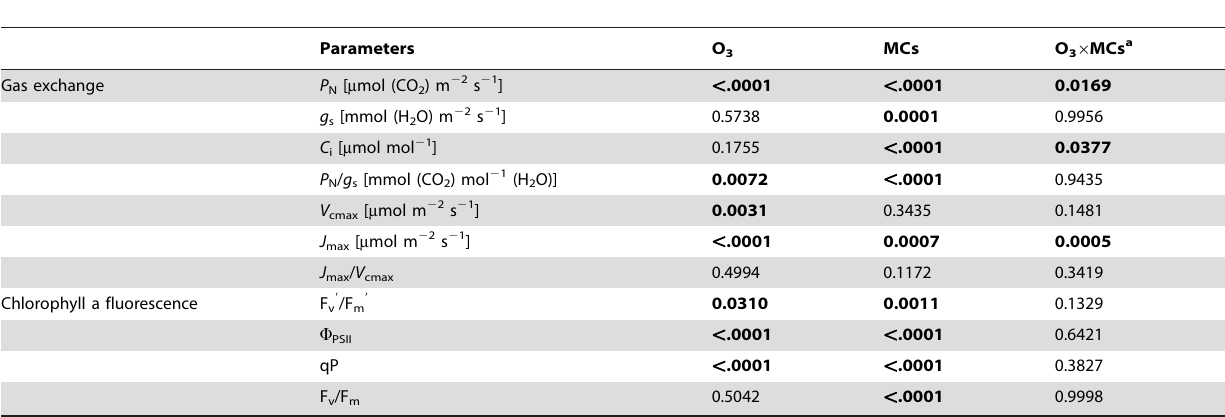
Table 2. Repeated measures ANOVAs (RANOVAs) of the gas exchange and chlorophyll a fluorescence parameters of Cinnamomum camphora seedlings during the 2010 growing season ( P values are shown, n = 4 for V cmax , J max and J max / V cmax , n =6 for other